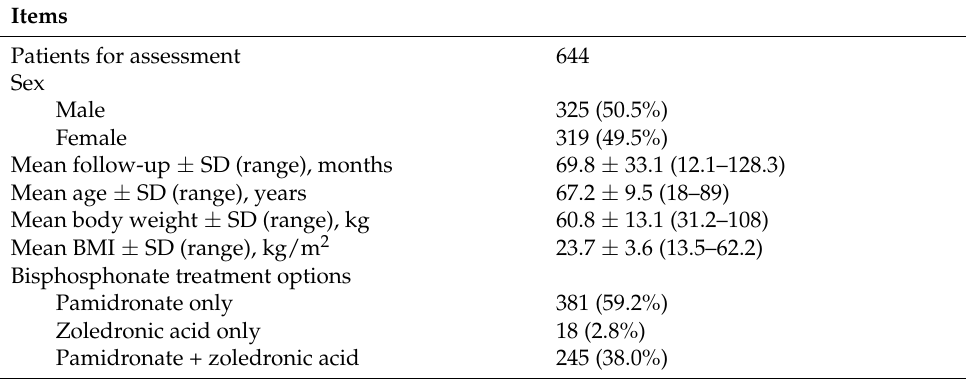
Table 1. Demographics of 644 patients eligible for analysis.